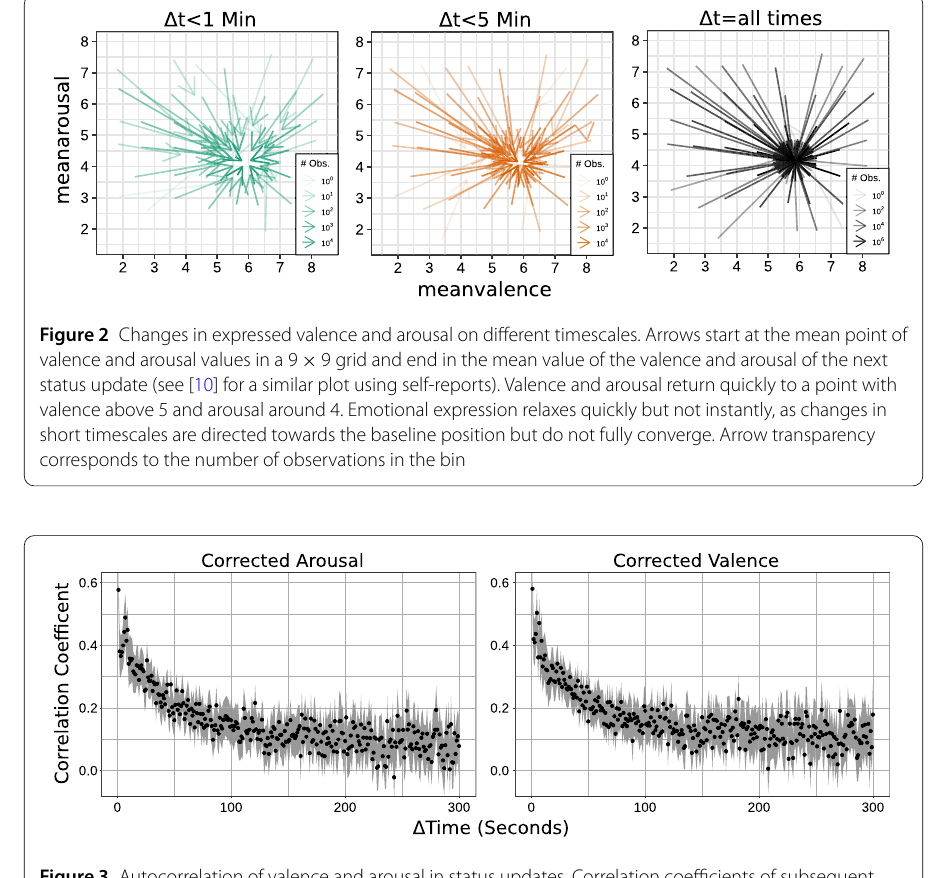
Figure 3 Autocorrelation of valence and arousal in status updates. Correlation coefficients of subsequent status updates by the same user (correcting for individual baselines) after (cid:4) t seconds passed between them. Shaded areas are 95% bootstrap confidence intervals. There is strong correlation between two subsequent status updates at a very fast time scale. If time between status updates increases, both correlation coefficients decrease and quickly become